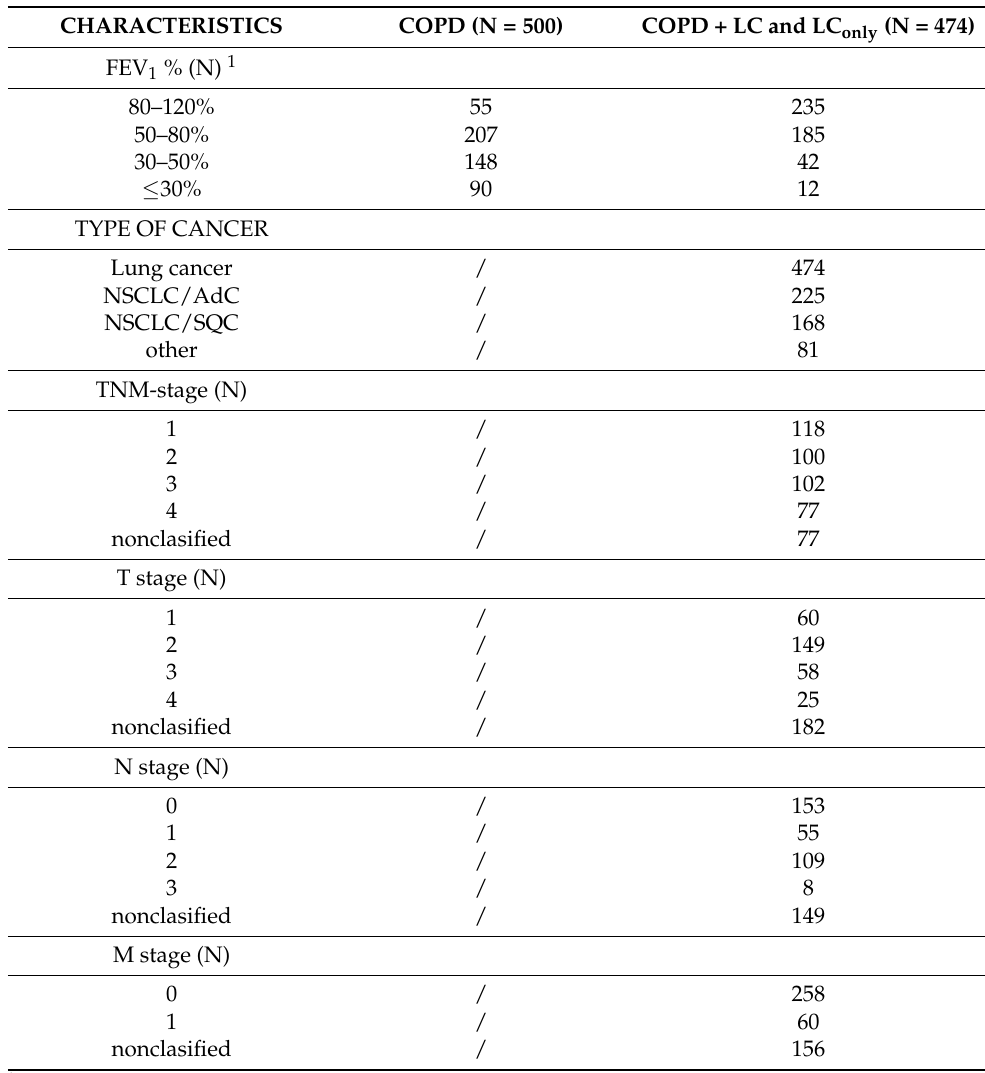
Table 2. Clinical characteristics of the tested